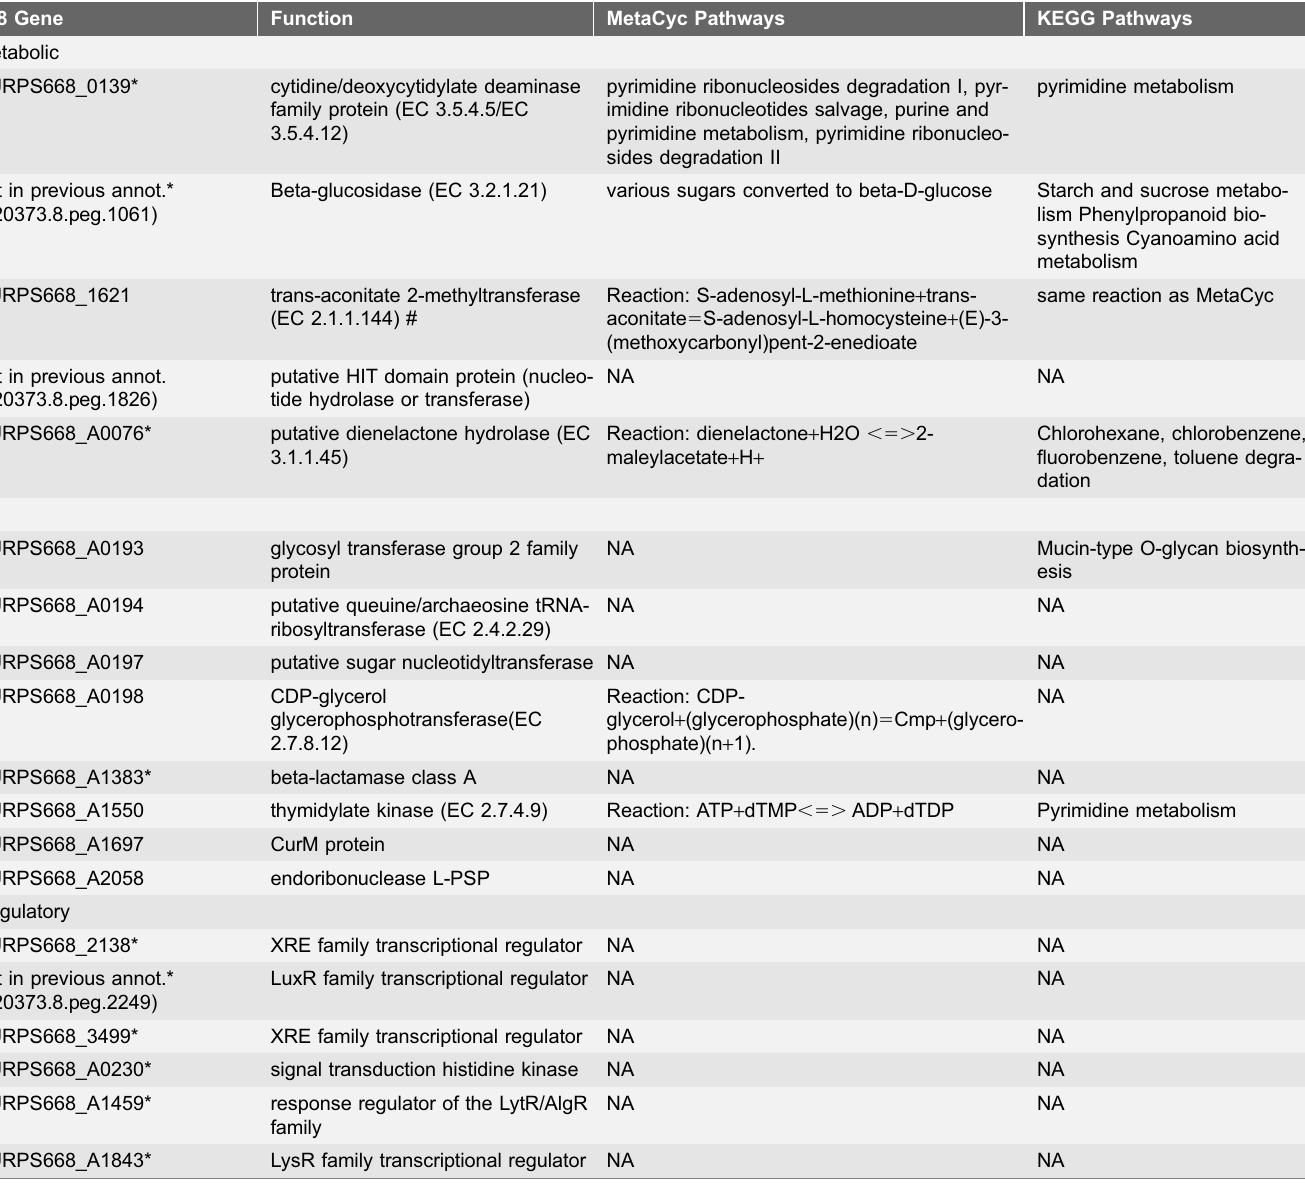
Table 5. Metabolic and regulatory genes in the MSHR668 genome that were not present in either K96243 or 1106a. 668